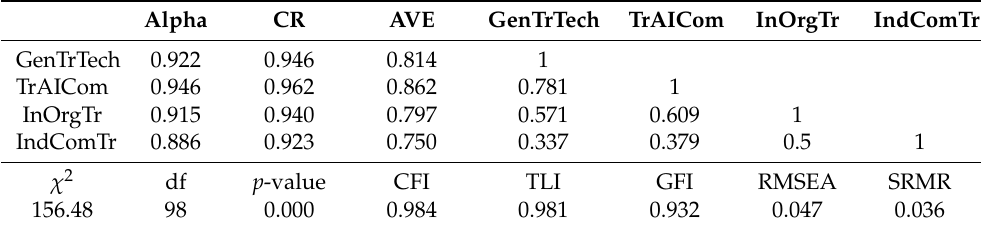
Table 2. Score reliabilities, validities and correlations of latent variables and values of selected fit statistics for CFA